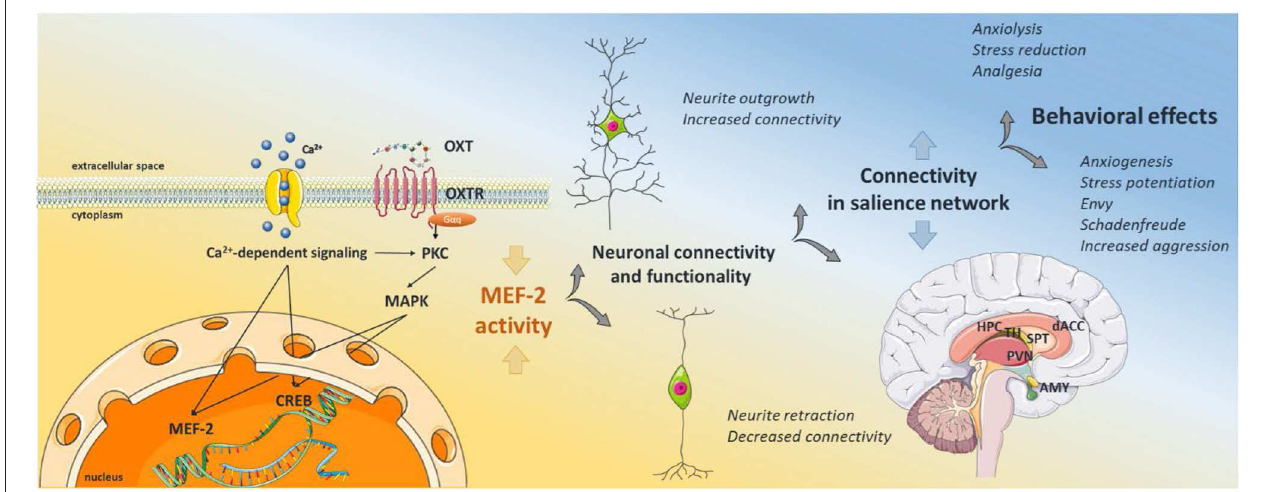
FIGURE 1 | Graphical Abstract of the proposed signaling scheme. Oxytocin binds its receptor, which transactivates different types of calcium channels, leading to calcium influx from the extracellular space. Calcium activates protein kinase C, and subsequent MAPK pathway activation, i.e., MEK1/2-ERK1/2, which translocates to the nucleus and activates the transcription factor CREB. Calcium also activates the calcium-dependent phosphatase calcineurin, which dephosphorylates and therefore activates MEF2. Active MEF2 increases gene transcription of negative regulators of synaptic structures, causing decreased neurite outgrowth, synapse number, and hypoconnectivity between neighboring neurons. As oxytocin receptor positive neurons are located within brain regions of the salience network, MEF2 activity regulates the connectivity within those regions, dampening or increasing the activity in the whole network. Depending on the emotional context of external stimuli, those changes in the salience network can cause alleviating or adverse behavioral responses. The schematic art pieces used in this figure were provided by Servier Medical art (http://servier.com/Powerpoint-image-bank). Servier Medical Art by Servier is licensed under a Creative Commons Attribution 3.0 Unported